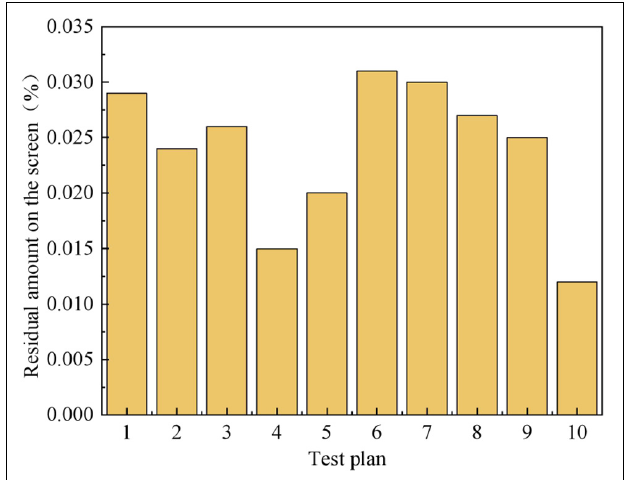
FIGURE 2 | Amount of screen residue of the CEASM after storage for 10